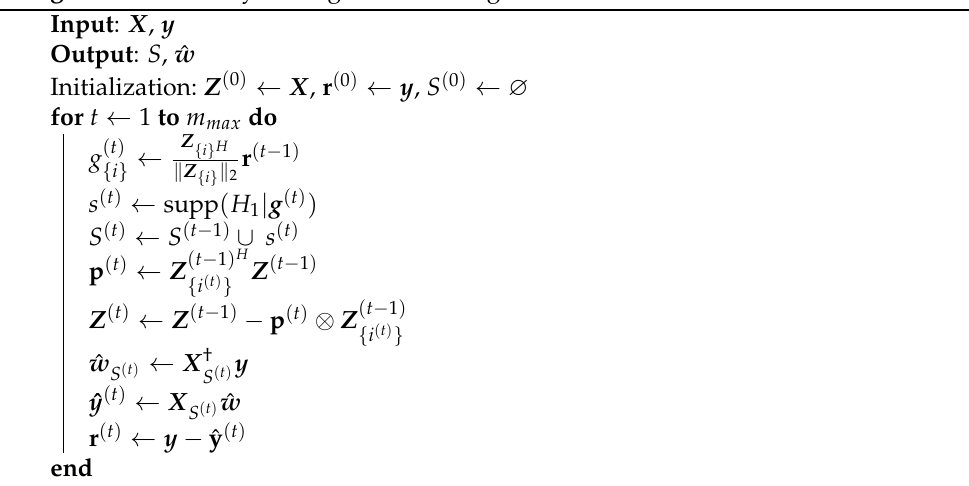
Algorithm 2: Doubly Orthogonal Matching